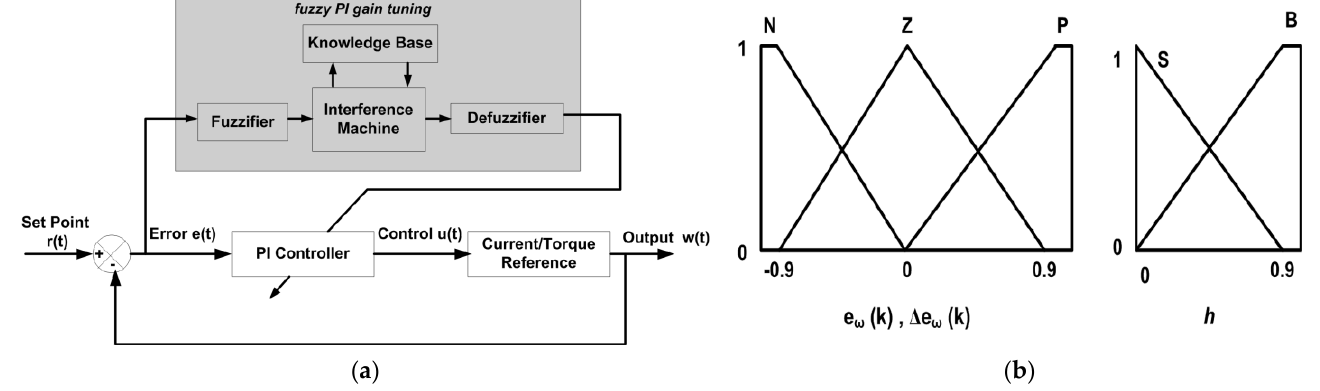
Figure 3. Adaptive Fuzzy-PI controller. ( a ) Structure of Adaptive Hybrid Fuzzy-PI Controller. ( b ) Membership